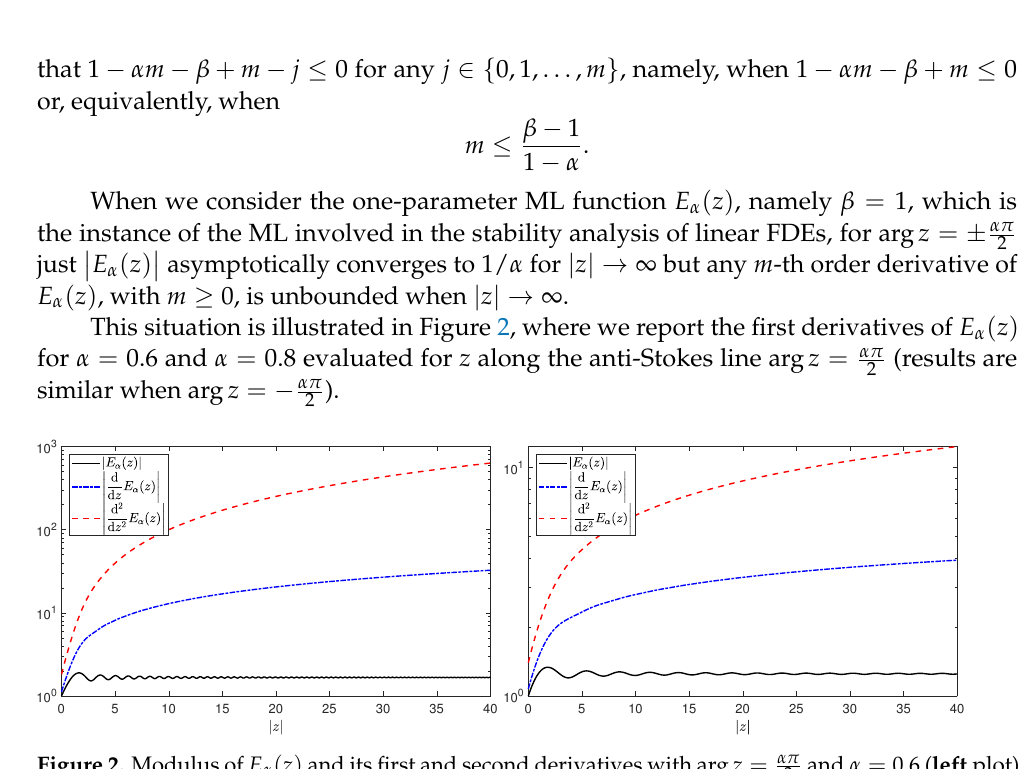
and α = 0.6 ( left plot) 2